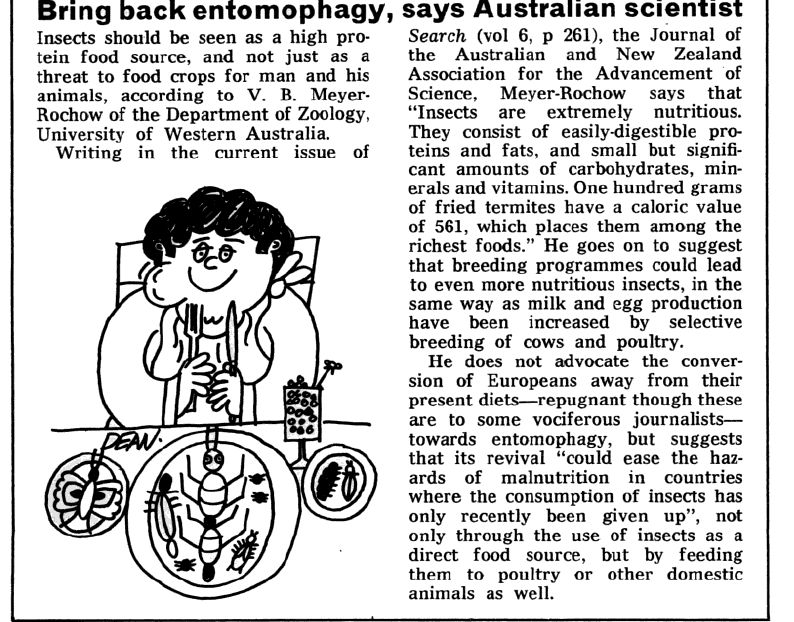
Figure 1. One of many cartoons that appeared in newspapers and magazines [12] after it had been suggested that insects could ease the problem of food shortages. suggested that insects could ease the problem of food